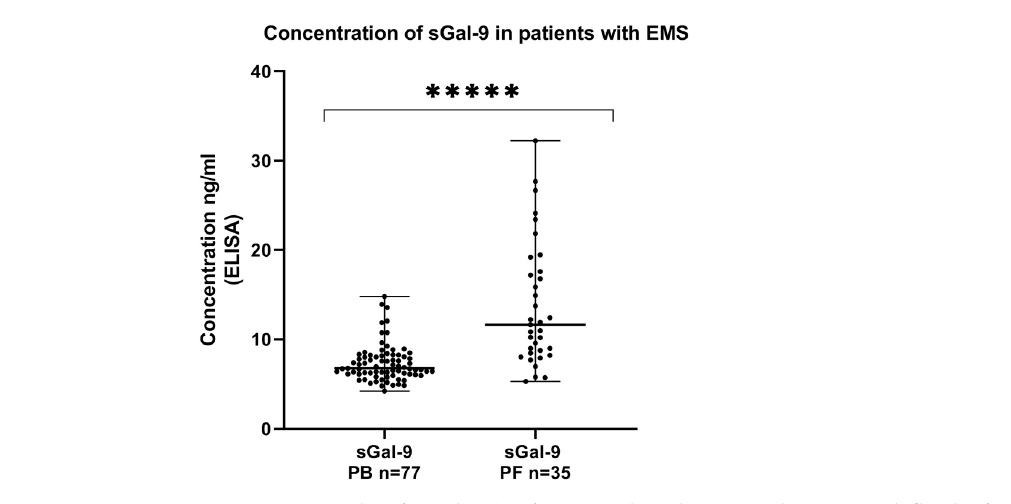
Figure 5. Levels of sGal-9 (ng/mL) in the plasma of patients with endometriosis and control group. The median value with the following signs indicate statistically signi fi cant di ff erences: *** p < 0.001.